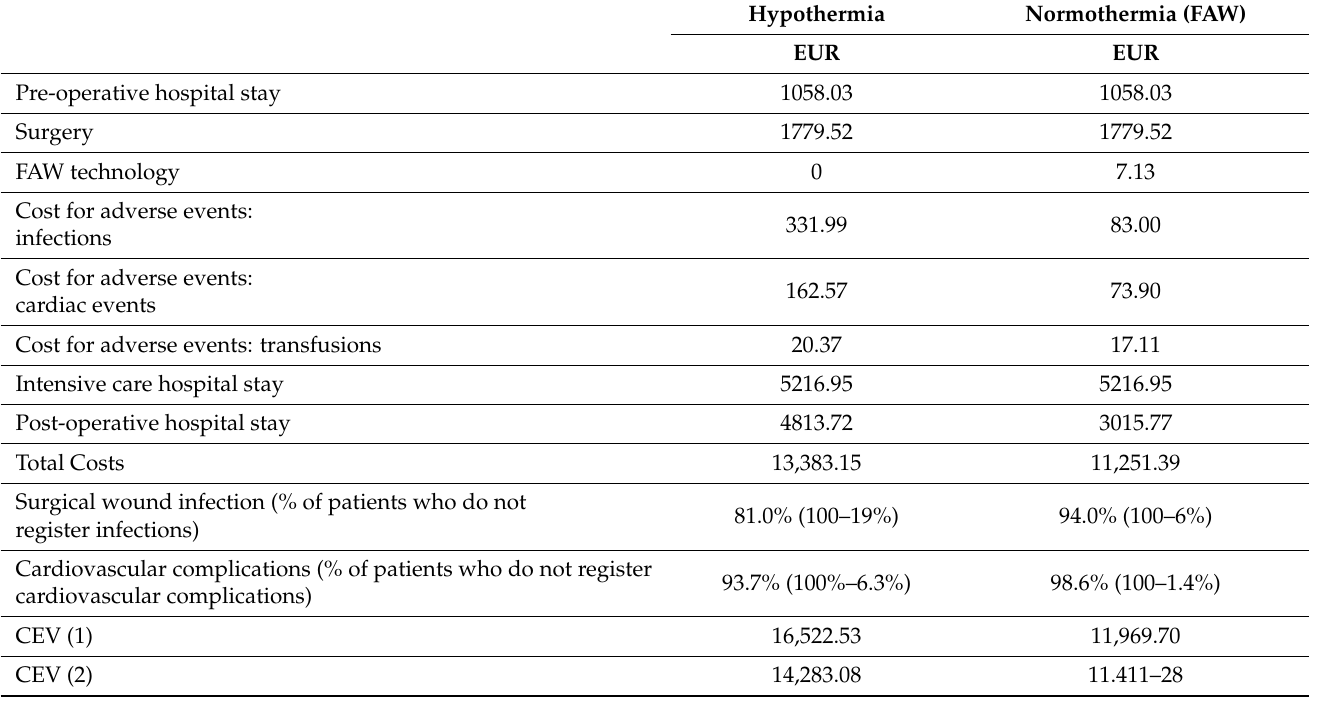
Table 4. Economic evaluation—Activity Based Costing analysis and Cost-Effectiveness